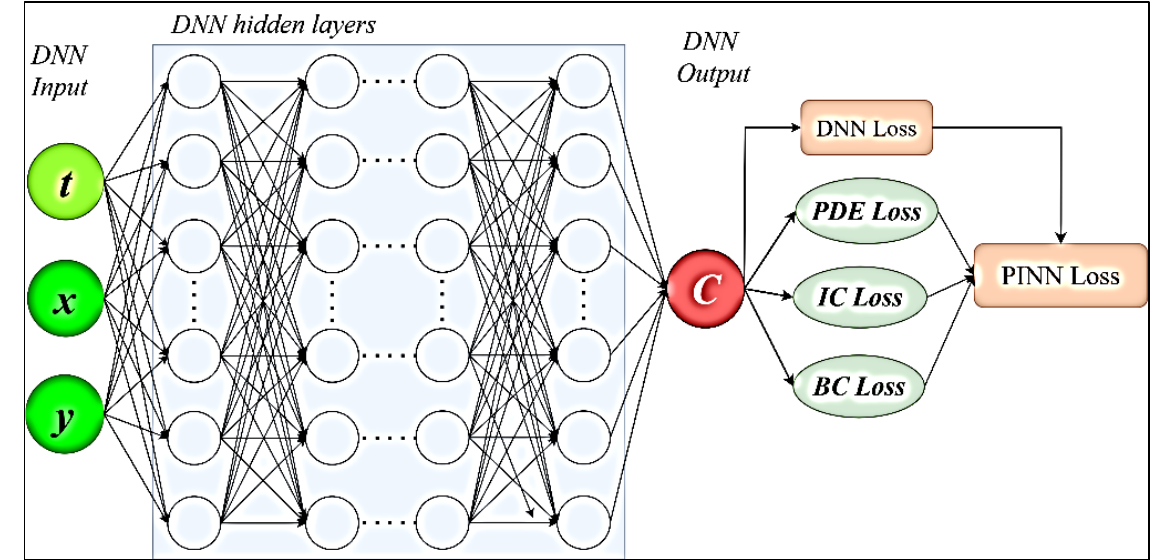
Figure 5. Schematic representation of PIML framework (here t is the drying time, x and y is the two dimensional axis, and C is liquid conentation (mol/m 3 )).